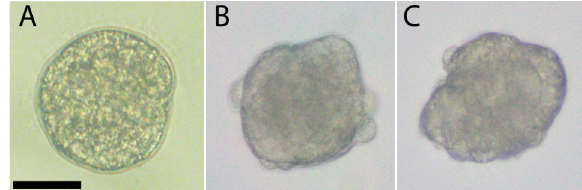
Fig. 2. Typical Saccostrea glomerata trochophores exposed to (A) ambient seawater, (B) pH 4.8 seawater for 2 h and (C)